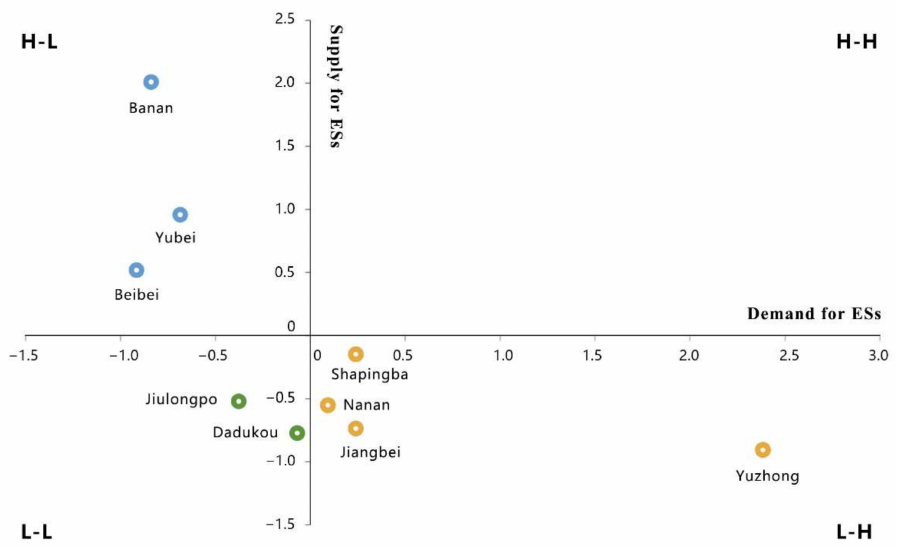
Figure 7. Supply–demand types of